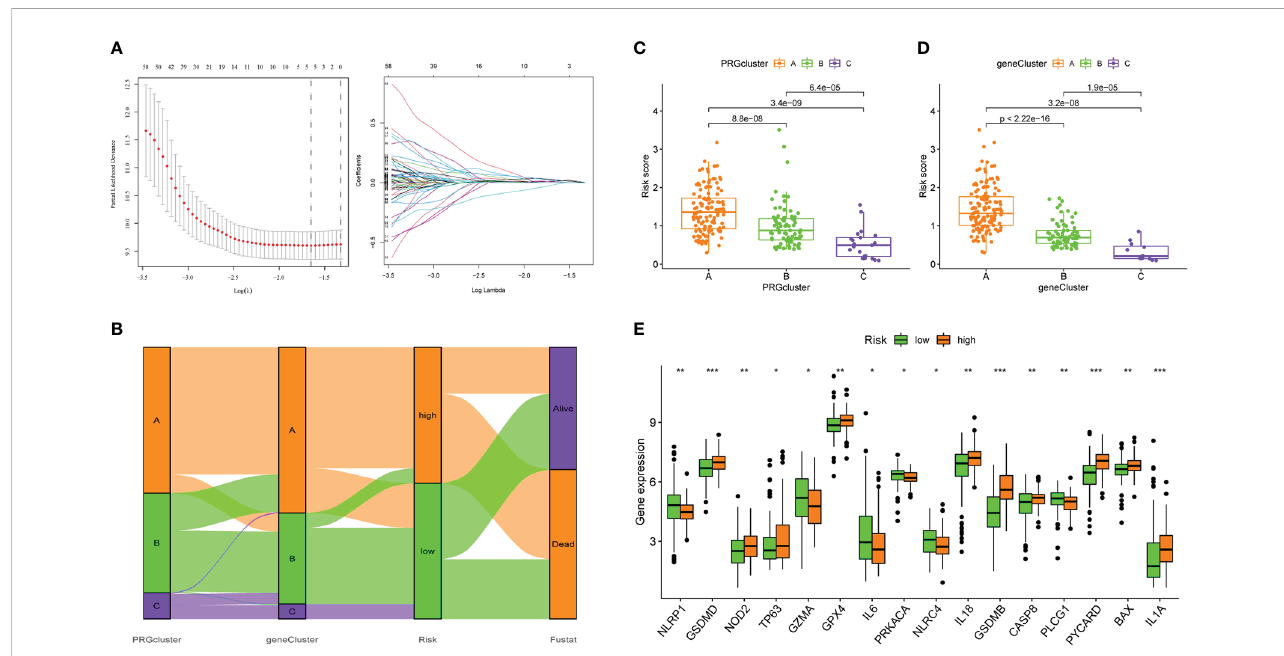
FIGURE 5 The establishment of PMSRPS and its relationship to molecular subtypes and PRGs. (A) Lasso regression analysis. (B) The Venn plot shows the relationship between molecular subtypes and risk score as well as survival state. (C) Distribution of risk scores among three PRGclusters. (D) Differences in risk scores among three geneClusters. (E) Differences in PRGs expression between the high- and low-risk groups. * P < 0.05, ** P < 0.01, *** P < 0.001.